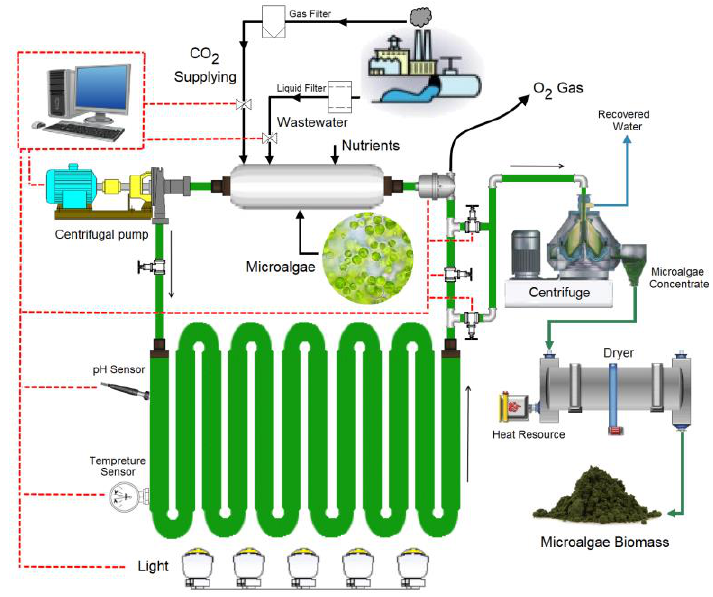
Fig. 1. MCV cultivation and biomass production